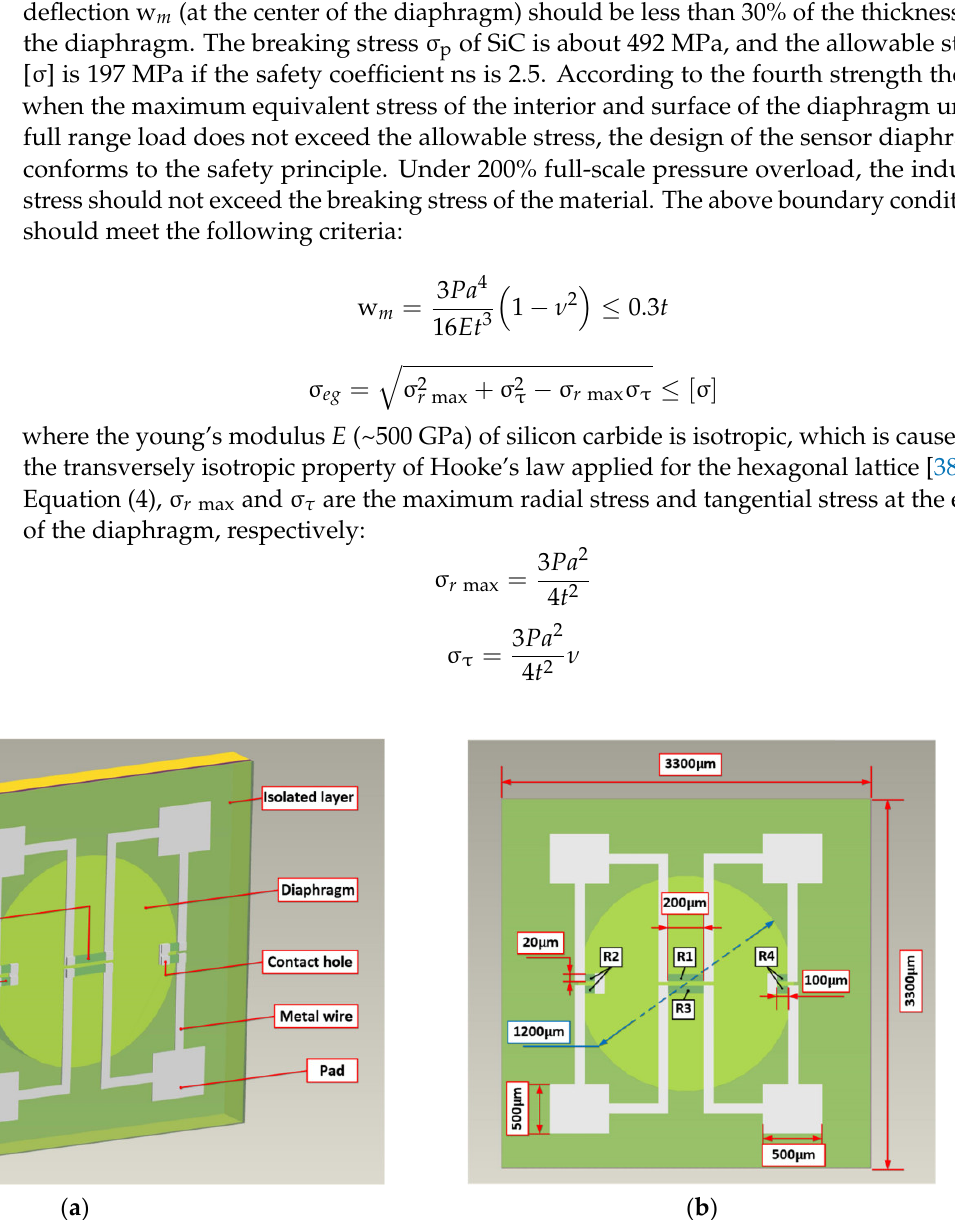
Figure 1. ( a ) Schematic diagram and ( b ) dimension diagram of the 4H-SiC piezoresistive sensor chip. The isotropy of the piezoresistive effect of 4H-SiC in each crystal direction of the (0001) plane is attributed to its wurtzite lattice in the 6mm point group [39]. Nevertheless,